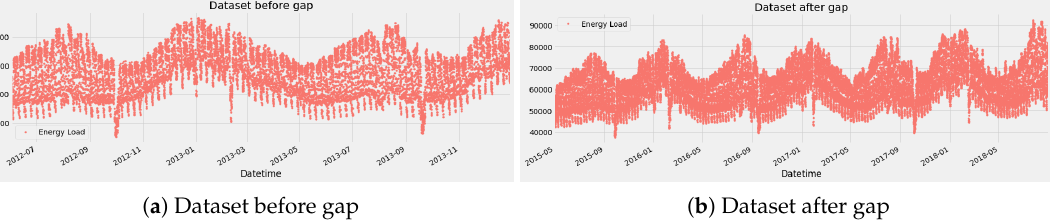
Figure 6. Division of data into two